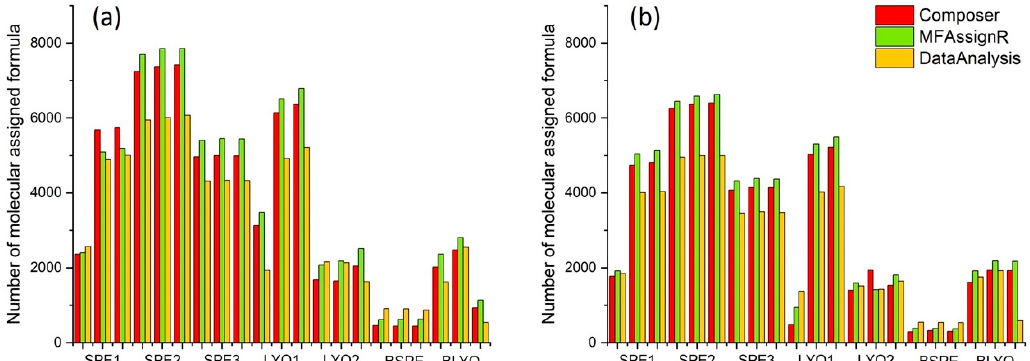
Figure 2. ( a ) Number of assigned molecular formulas for peak-lists extracted with S/N (signal to noise) 5 and ( b ) number of assigned molecular formulas for peak-lists extracted with S/N 7. Red bars indicate results obtained with Composer, green bars results obtained with MFAssignR, and yellow bars results obtained with DataAnalysis.